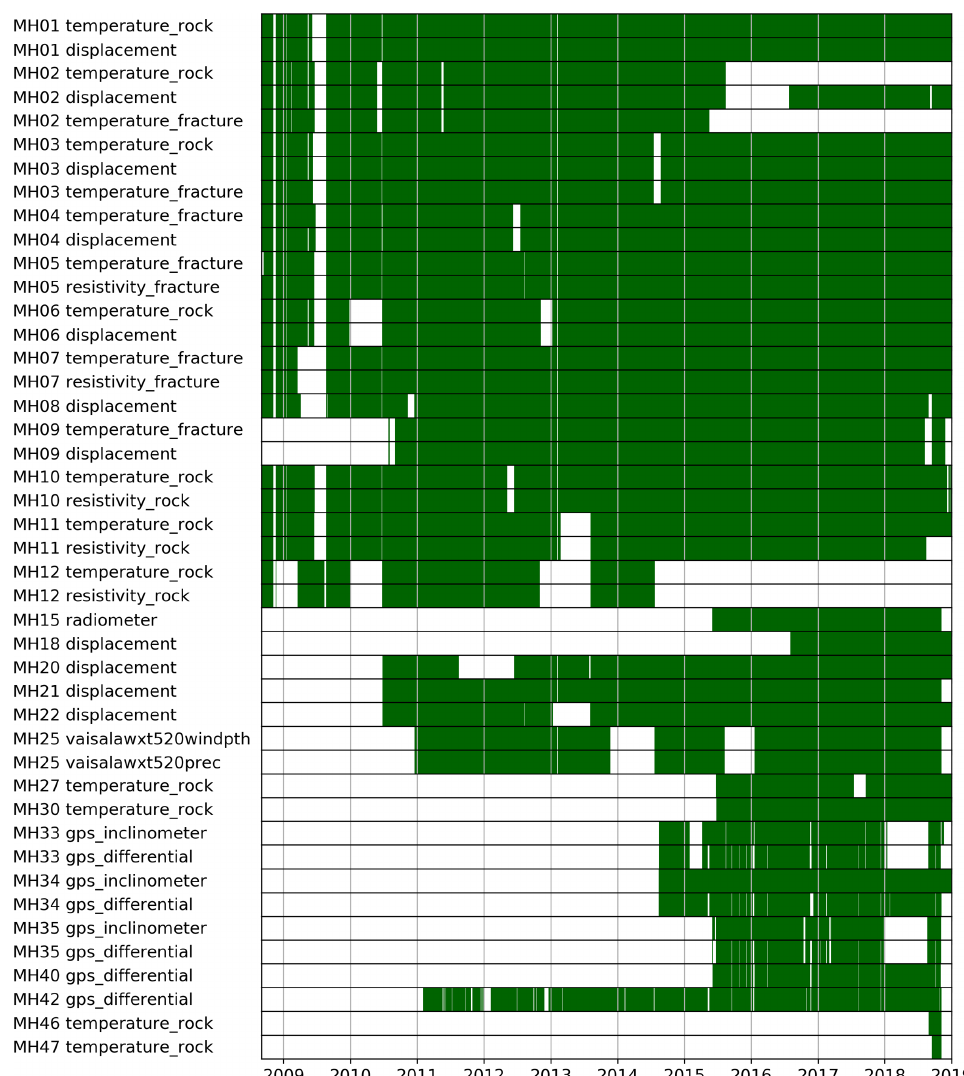
Figure 6. Data availability for all data products. The time periods when data are available are indicated in green.